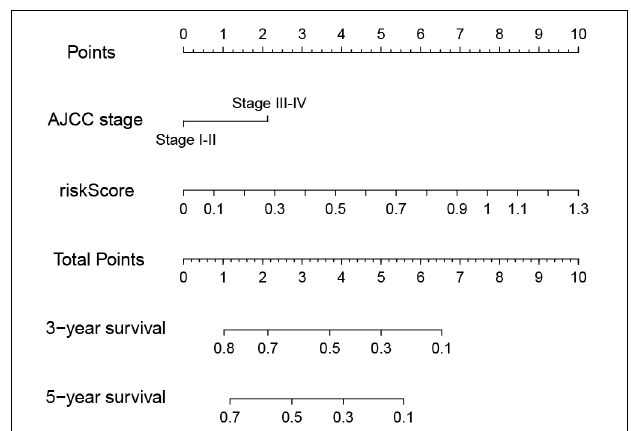
FIGURE 6 | Predictive nomogram for OS in the training group. OS, Overall